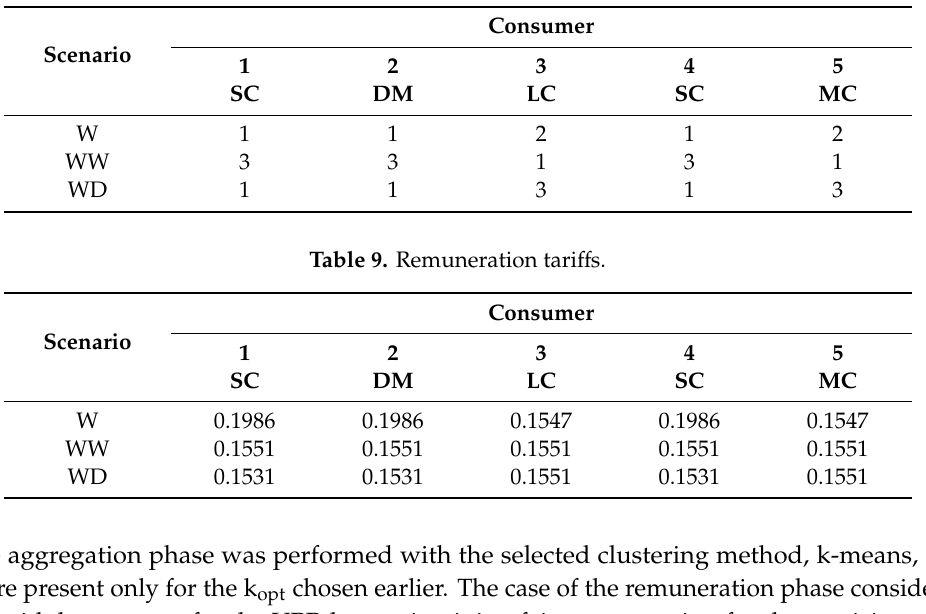
Table 8. Aggregation groups. WW, whole week, W weekend; WD, week days.